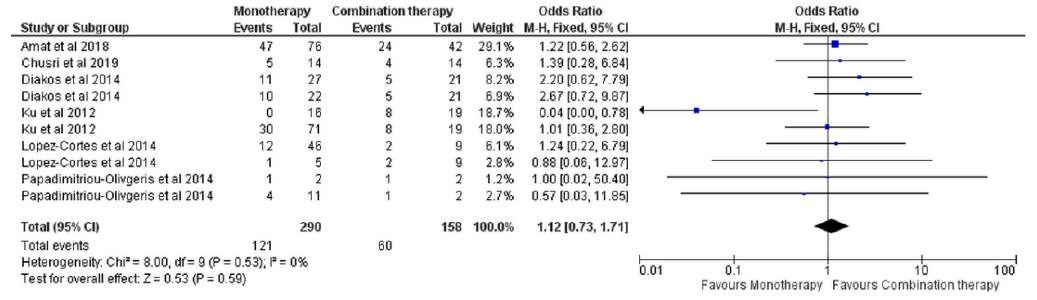
Figure 7. No significant heterogeneity was observed (I 2 = 0%, p = 0.53). Possible publication bias was observed, Figure S1.9, and when this was improved by excluding the subgroup of Ku et al. [15], with OR = 0.04, 95% CI [0.00, 0.78], the outcome did not change (OR =